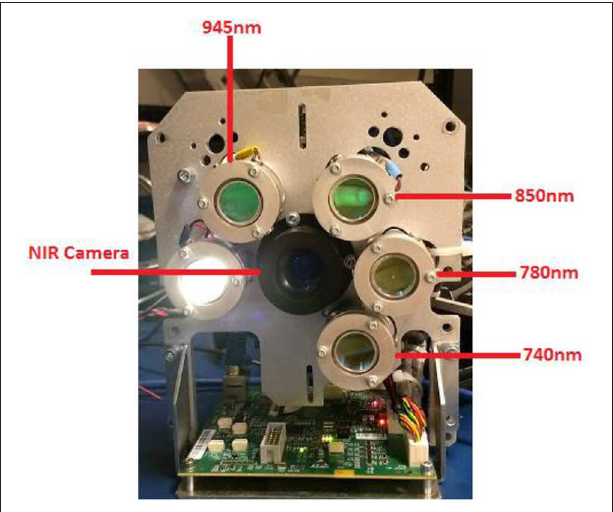
FIGURE 1 | Image of the commercial multispectral imaging system (Presygen TM